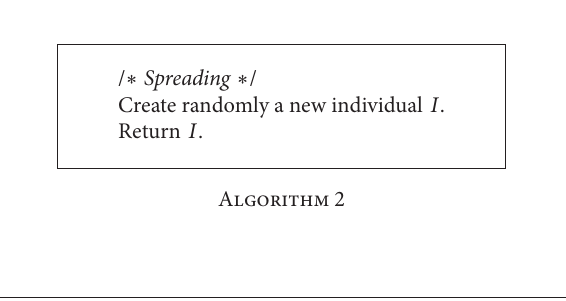
Figure 1: Flowchart of the